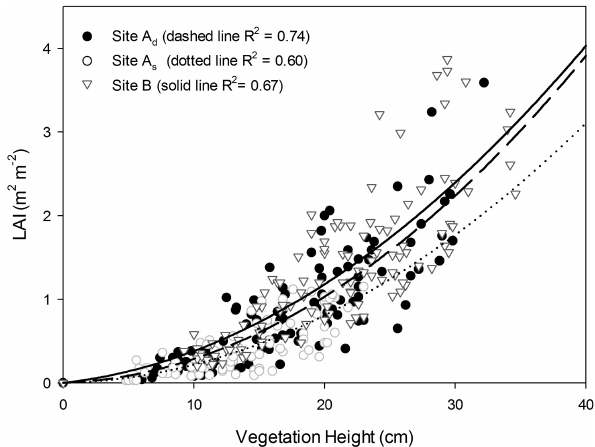
Figure 1. Relationships between vegetation height ( H ) and leaf area index (LAI); the equations for the fitted regres- sion lines are for Site A d : LAI = 0.0023 × H 2 + 0.0056 × H ; Site A s : LAI = LAI = 0.0019 × H 2 + 0.003 × H and Site B: LAI = 0.0021 × H 2 + 0.0171 × H